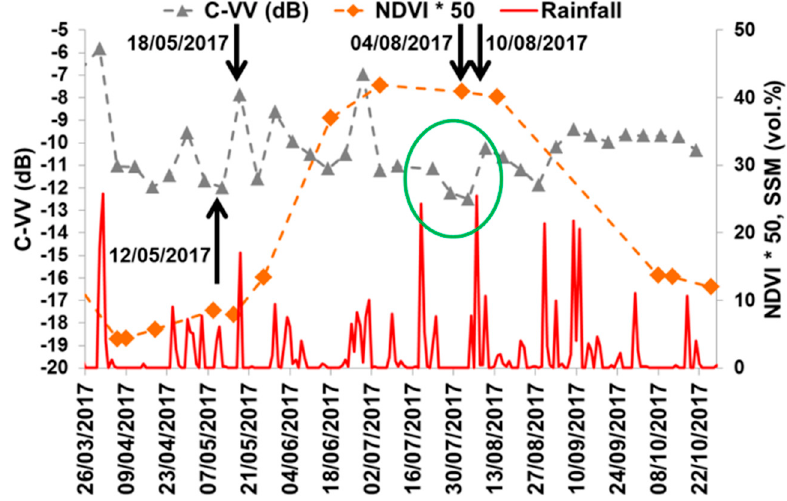
Figure 6. Temporal behavior of the radar signal in the C-band and VV polarization over a nonirrigated maize plot. The vertical lines in red represent the rainfall events. To display NDVI and SSM values on the same axis, the NDVI-values were multiplied by 50.